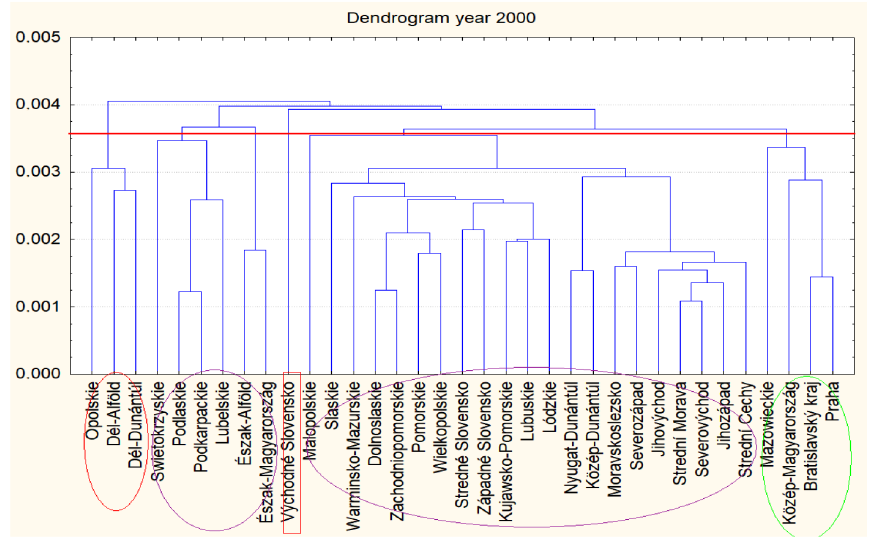
Figure 1. Dendrogram – year